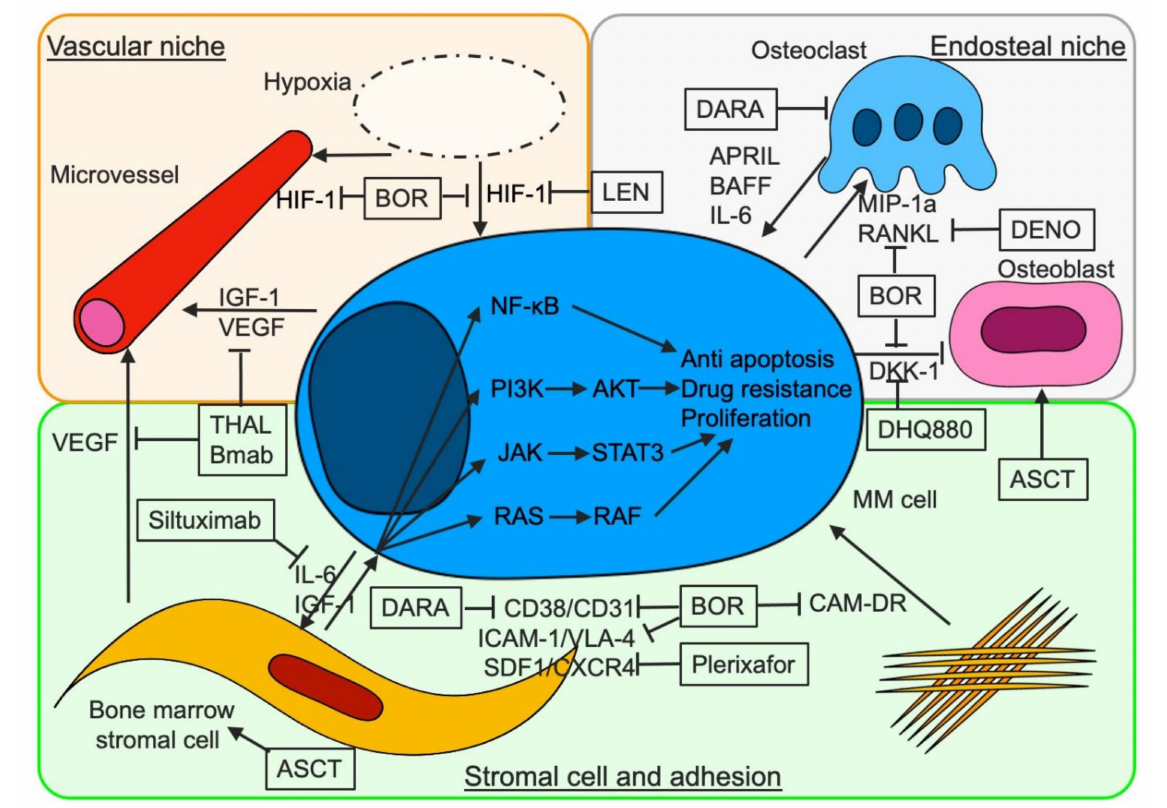
Figure 1. Therapeutics for bone marrow microenvironment associated with the progression and survival of myeloma cells. Stromal cells contribute to the proliferation, survival, and resistance against therapeutics in myeloma cells through the acti- vation of several signaling pathways, cell adhesion-mediated drug resistance (CAM-DR), and soluble factor-mediated drug resistance (SFM-DR). BOR, DARA, and plerixafor overcome CAM-DR by inhibiting VLA-4, CD38, and CXCR4, respectively. BOR inhibits CD38-CD31-mediated adhesion of myeloma cells to bone marrow stromal cells (BMSCs) and increases CD38 expression on myeloma cells by decreasing BMSC CD31 expression. Under hypoxic conditions, HIF-1 promotes VEGF tran- scription, which induces the growth of microvessels and contributes to the proliferation of myeloma cells. IGF-1 contributes to the growth of microvessels through the activation of HIF-1alpha. Hypoxia is associated with stemness of myeloma cells. BOR suppresses transcription of HIF-1 alfa and indirectly inhibits myeloma angiogenesis via decreasing levels of VEGF. THAL inhibits angiogenesis by suppressing transcription of the VEGF gene. Bevacizumab suppresses the interaction between VEGF and VEGFR. Myeloma cells activate osteoclasts and inhibit osteoblasts, which constitute the endosteal niche. In addition, several cytokines from osteoclasts contribute to the proliferation of myeloma cells. BOR suppresses osteogenesis via inhibition of RANKL and DKK-1. DENO and BHQ088 inhibit RANKL and DDK-1, respectively. ASCT contributes to the improvement of BM environment by supplying mesenchymal cells and remodeling the endosteal niche. Mesenchymal stem cells, which are provided from autografts, contribute to the remodeling of bone marrow stromal cells and the activation of osteoblasts. BOR, bortezomib; THAL, thalidomide; IMiDs, immunomodulatory drugs; LEN, lenalidomide; DARA, daratu- mumab; DENO, denosumab; ASCT, autologous stem cell transplantation; Bmab, bevacizumab; CAM-DR, cell-adhesion mediated drug resistance; VEGF, vascular endothelial growth factor; IGF-1, insulin-like growth factor-1; HIF-1, hypoxia inducible factor-1; VLA-4, very late antigen 4; ICAM-1, intercellular adhesion molecule-1; CXCR4, C-X-C chemokine receptor type 4; SDF-1, stromal cell-derived factor-1; IL, interleukin; APRIL, a proliferation-inducing ligand; BAFF, B cell activating factor; RANKL, receptor activator of nuclear factor kappa-B ligand; MIP-1alpha, macrophage inflammatory protein 1alpha; DKK-1,